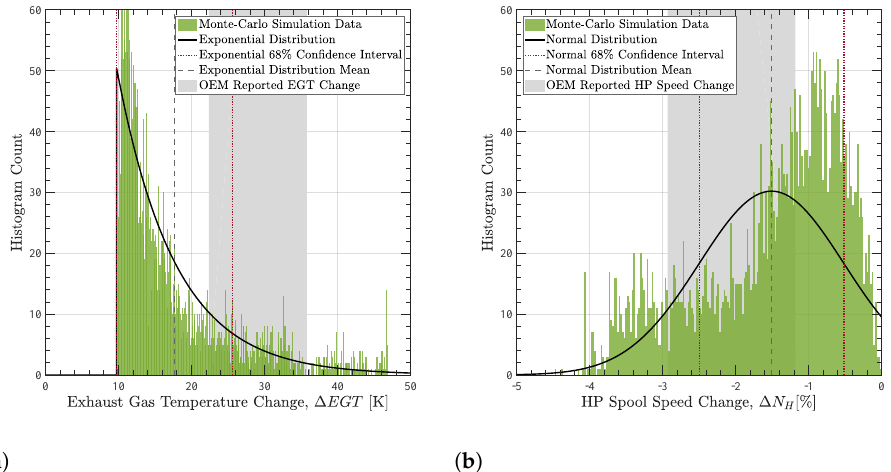
Figure 6. Model predicted change in exhaust gas temperature ( a ) and high-pressure spool speed ( b ) for the Mount Galunggung encounter event, with exponential and normal distributions, respectively, fit to the data and a comparison between the mean performance change predicted by the model and the range observed for the four engines involved in the